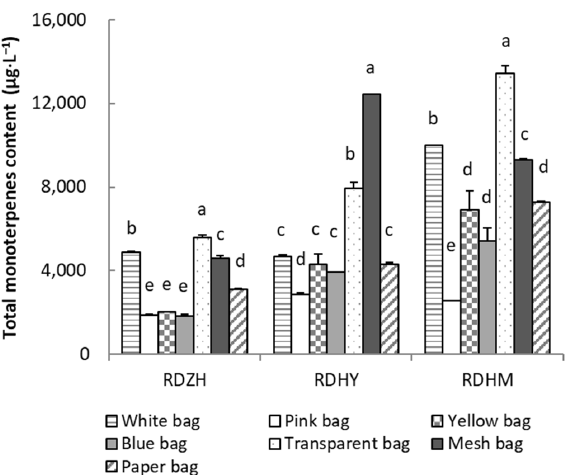
Figure 3. Effects of fruit bagging treatment with different types of bags on the total contents of monoterpenes in the three table grape cultivars. Different letters on the bars of certain cultivar stand for the significant difference ( p value < 0.05).